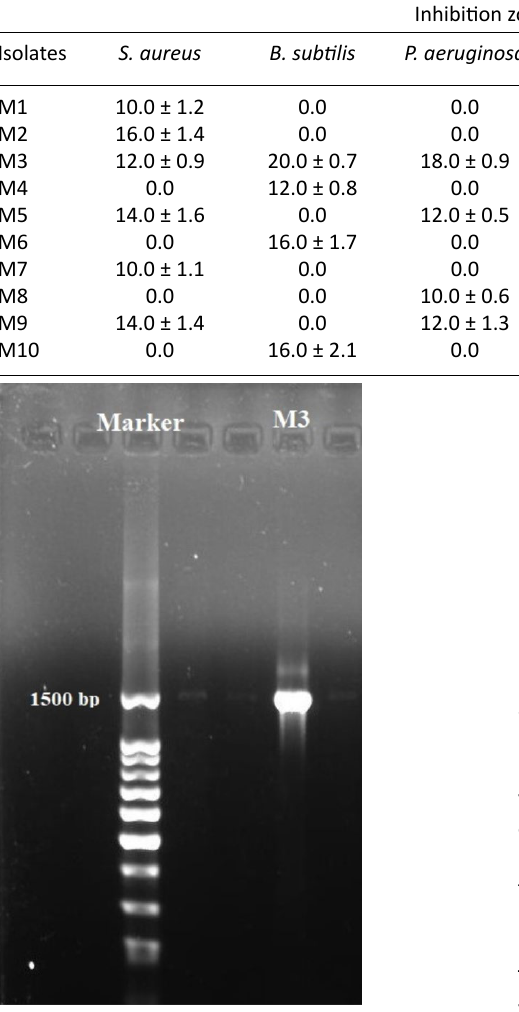
Fig. 5. Agarose gel electrophoreses of the amplified 16S rRNA gene of isolate M3.